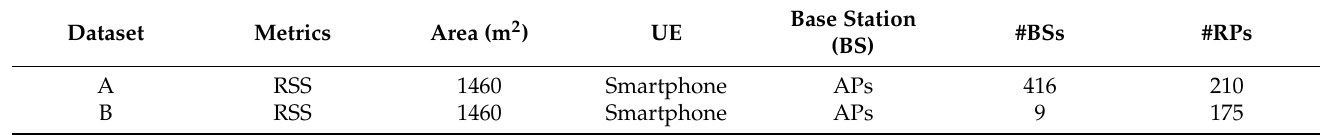
Table 1. Descriptive of the two real-office experiments at UESTC.